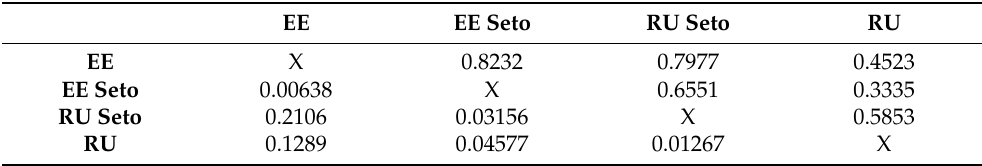
Table 3. P -values for Wilcoxon test (right top) and Kruskal–Wallis test (bottom left) for the compared ethnic